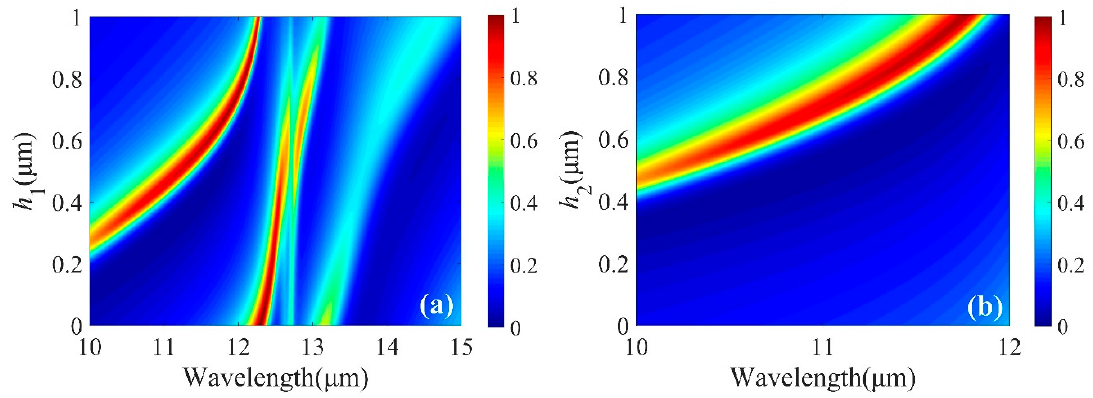
Figure 5. Absorption spectra for various height of ZnS with ( a ) amorphous (aGST) and ( b ) crystalline (cGST) stable structural phases, respectively.